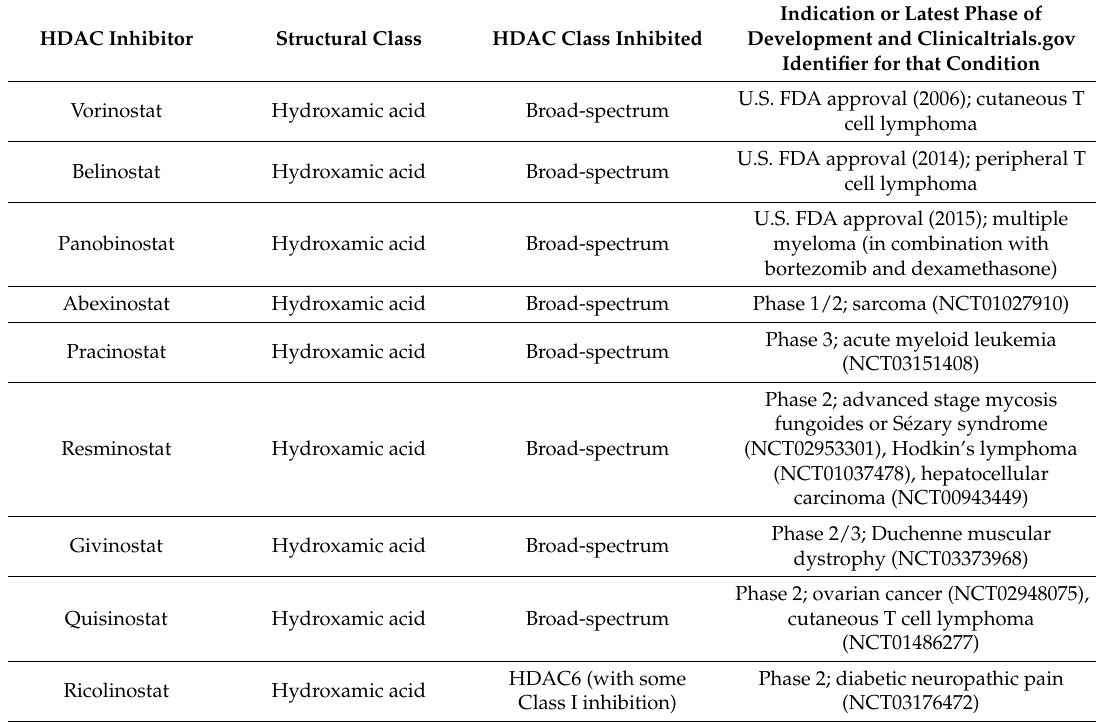
Table 1. Pharmacological HDAC inhibitors, structural class, HDAC classes inhibited and indication or latest stage of